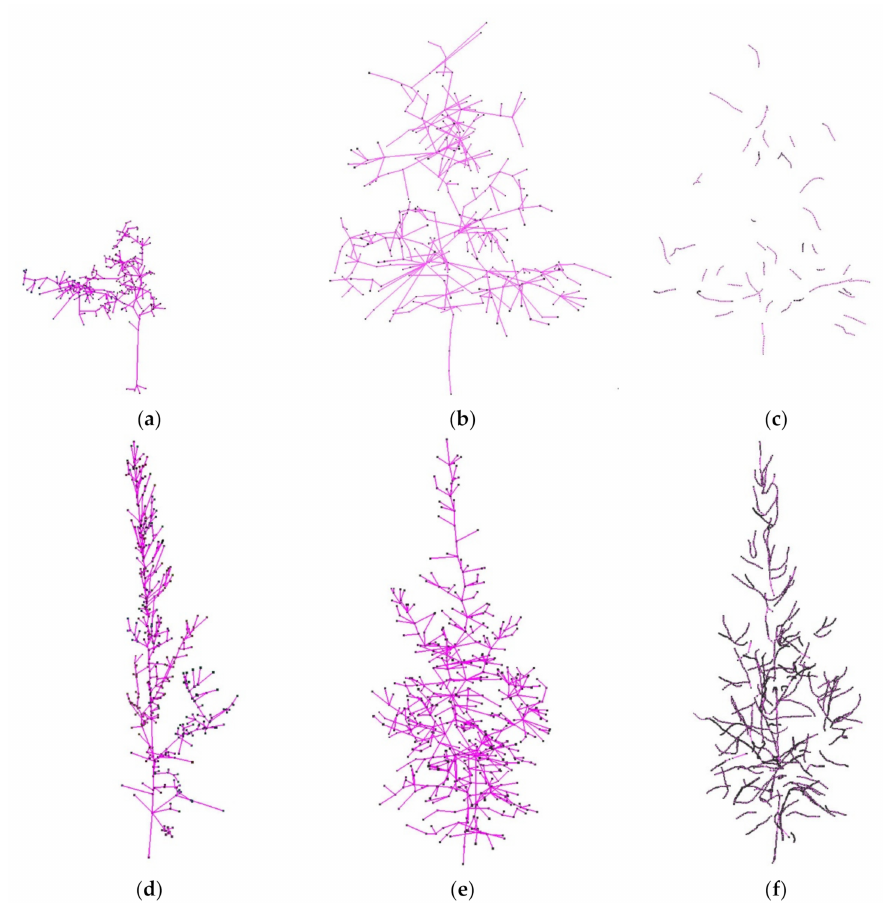
Figure 8. The results of state-of-the-art methods processing Data 1 and Data 2. ( a – c ) are obtained by SimpleTree, PypeTree, and L1-Skeleton from Data 1, respectively. ( d – f ) are generated by SimpleTree, PypeTree, and L1-skeleton from Data